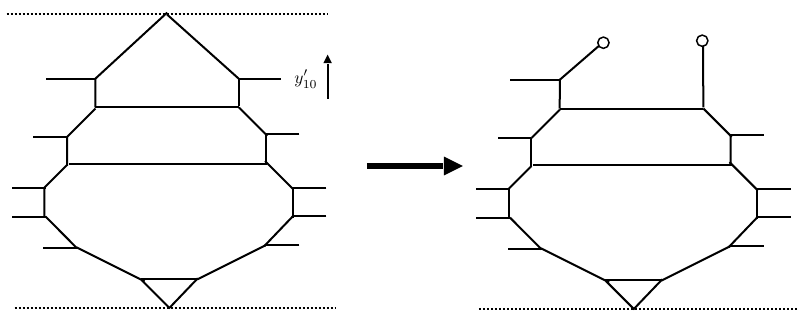
Figure 14 . A pictorial explanation of the decoupling limit from 10 flavors to 9